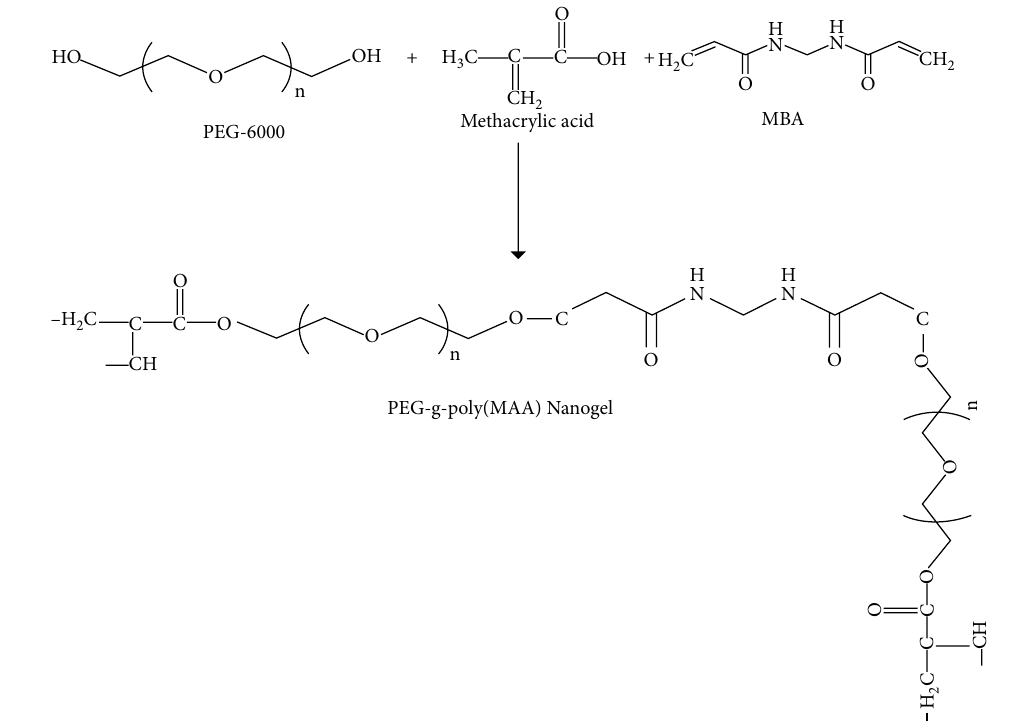
Figure 1: Proposed structure of PEG-g-poly (methacrylic acid) nanogels.